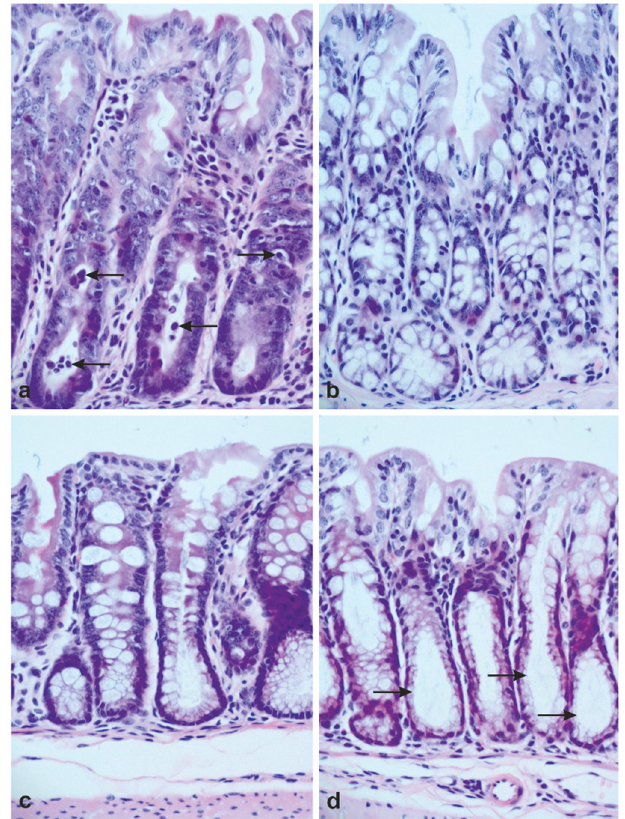
Figure 5. Targeting Wnt via Notch in a model of Casp8 deletion. ( a ) Severe cell death in the large intestinal mucosa of Casp8 f/f villinCre+ mice with deletion in Casp8 in intestinal epithelial cells (Casp8 ∆ int ). Arrows indicate examples of apoptotic bodies. ( b ) Typical features of normal large intestinal mucosa in Casp8 f/f villinCre- control littermates (Casp8 f/f ) with a high number of goblet cells. ( c ) Restoration of goblet cells in the large intestinal mucosa of Casp8 ∆ int animals treated with the Notch inhibitor dibenzazepine DBZ. ( d ) Large intestinal mucosa of Casp8 f/f mice after DBZ treatment with mucostatic features at crypts (arrows). Original magnification: 200×.